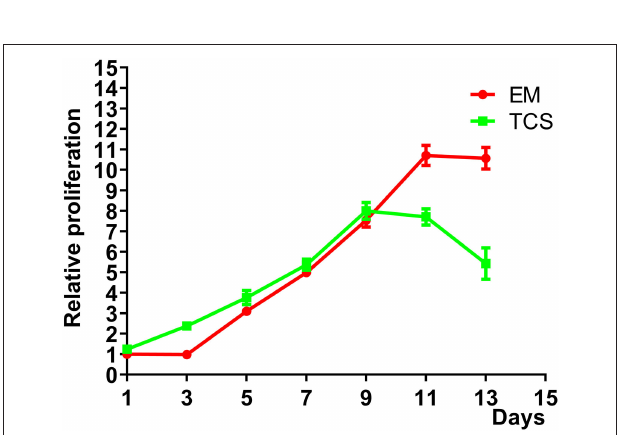
FIGURE 7 | Cell proliferation curves of L929 cells on EM, compared with that of culturing on